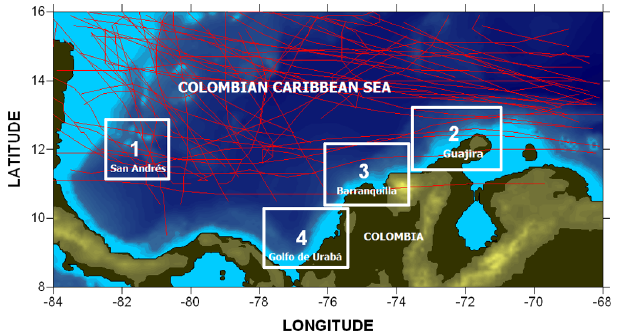
Fig. 2. Dynamics of cold fronts (Thompson,